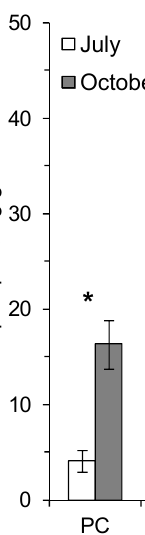
Figure 2. The contents (mg/g dry weight, standard error) of total phospholipids ( Ʃ PL), phosphatidylcholine—PC, phosphatidylinositol—PI, phosphatidylethanolamine—PE, phosphatidylglycerol—PG, phosphatidic acid—PA and diphosphatidylglycerol—DPG in the leaves